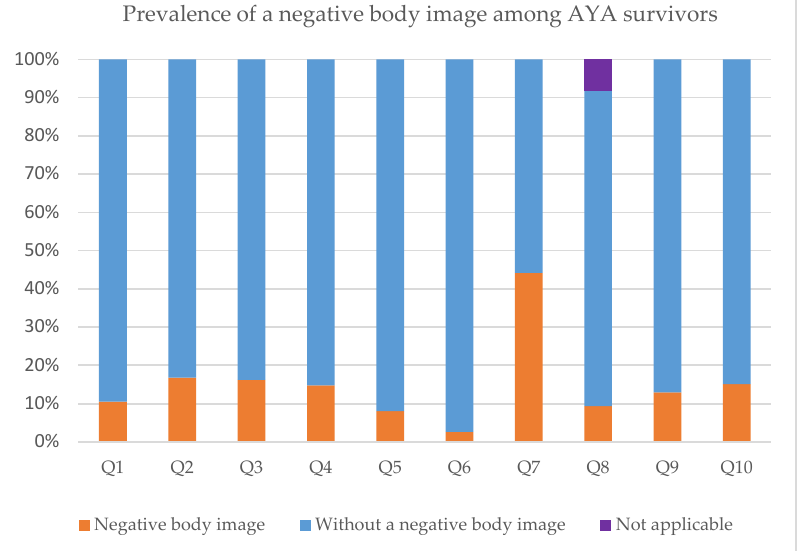
Figure 1. Prevalence of a negative body image among AYA survivors: Q1. Have you felt unattrac- tive? Q2. Have you felt older than your age? Q3. Have you been dissatisfied with your physical appearance? Q4. Have you felt that you could not trust your body? Q5. Have you felt embarrassed